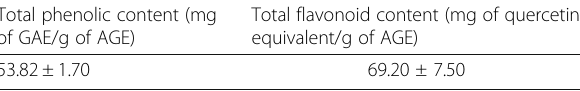
Table 4 Total Phenolic and total flavonoid content of AGE Total phenolic content (mg Total flavonoid content (mg of quercetin of GAE/g of AGE) equivalent/g of AGE) 53.82 ± 1.70 69.20 ± 7.50